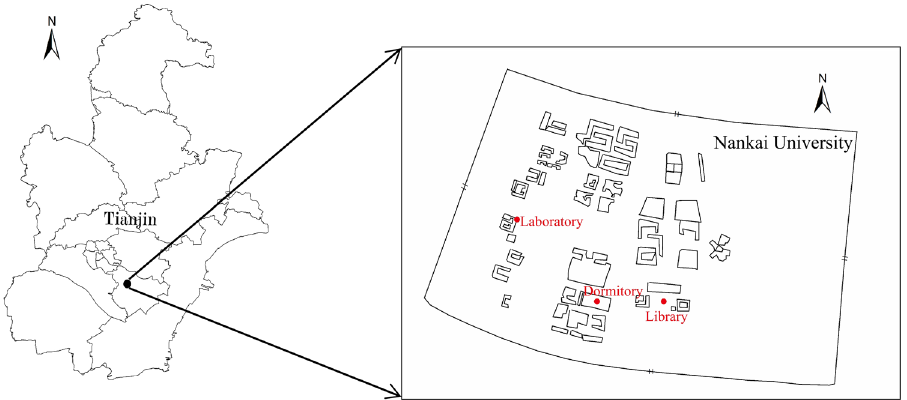
Figure 1. Sampling sites in this study (created by